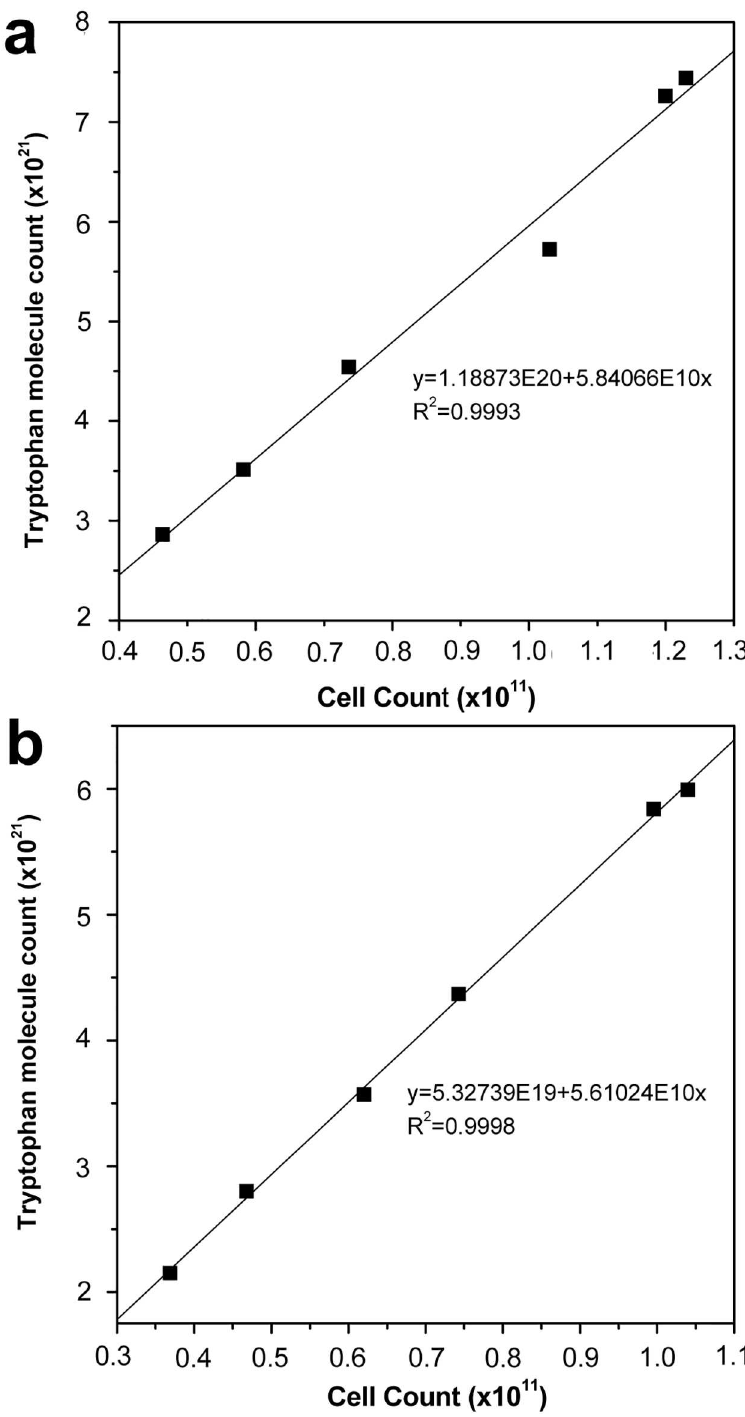
Fig 9. The linear relation of cell and tryptophan biosynthesis during cell recycling period (20–26h) with strategyI and III.